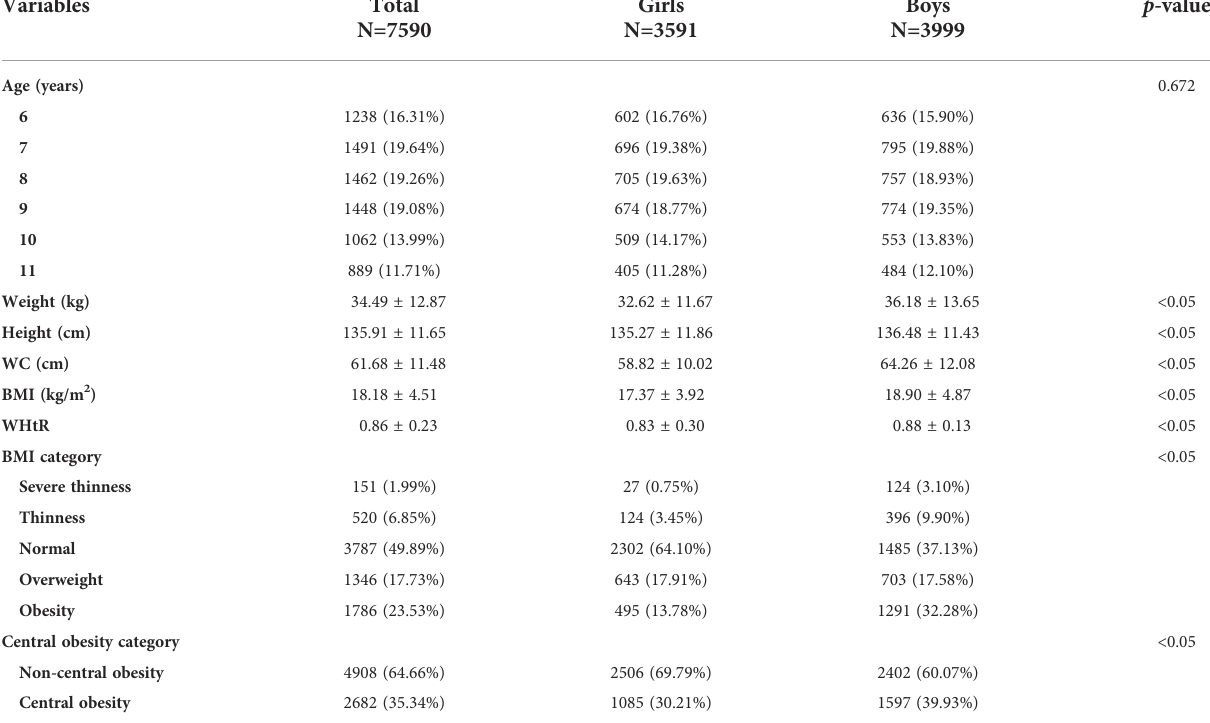
TABLE 1 Basic characteristics of the